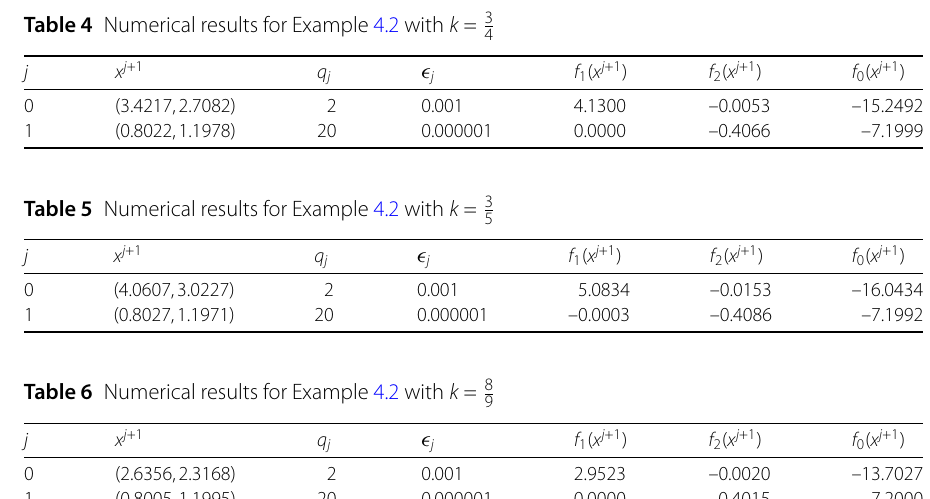
Table 4 Numerical results for Example 4.2 with k = 3